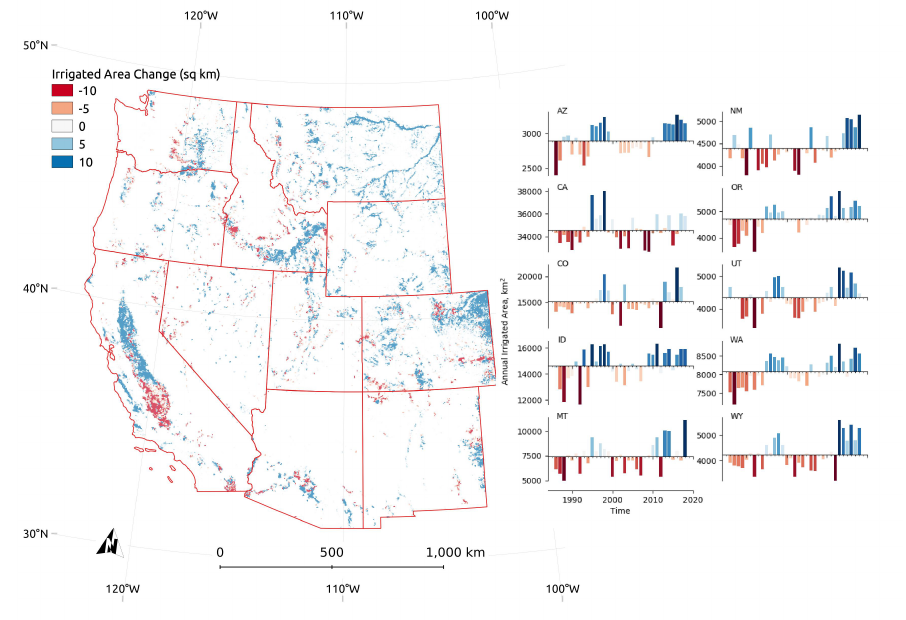
Figure 12. Change in ‘irrigation equipped’ area over the course of the study period, where locations with two or more years of detected irrigation in the periods 1986–1990 and 2014–2018 are considered